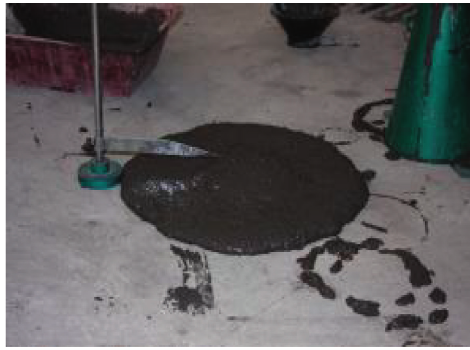
Figure 2: Slump meter test. Table 1: Orthogonal test design table of filling material ratio.